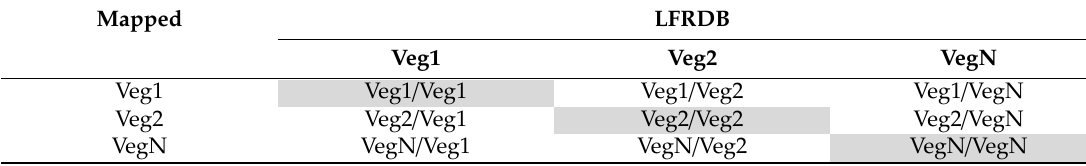
Table 3. Potential error matrix that calculates the agreement between a LANDFIRE-mapped vegetation product and withheld field-validated plots contained in the LANDFIRE Reference Database (LFRDB) for di ff erent vegetation classes ranging from vegetation classification 1-N (Veg1-VegN), where N indicates some number of vegetation classifications. Cell agreement between the LFRDB and modeled product are highlighted in